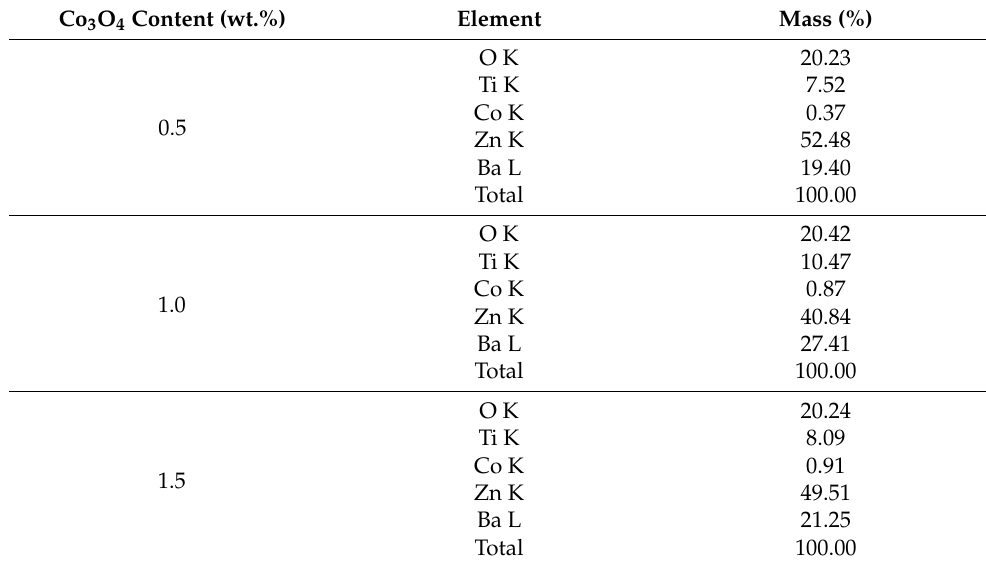
Table 2. The element contents of ZnO-BaTiO 3 varistor ceramics with different amounts of Co 3 O 4